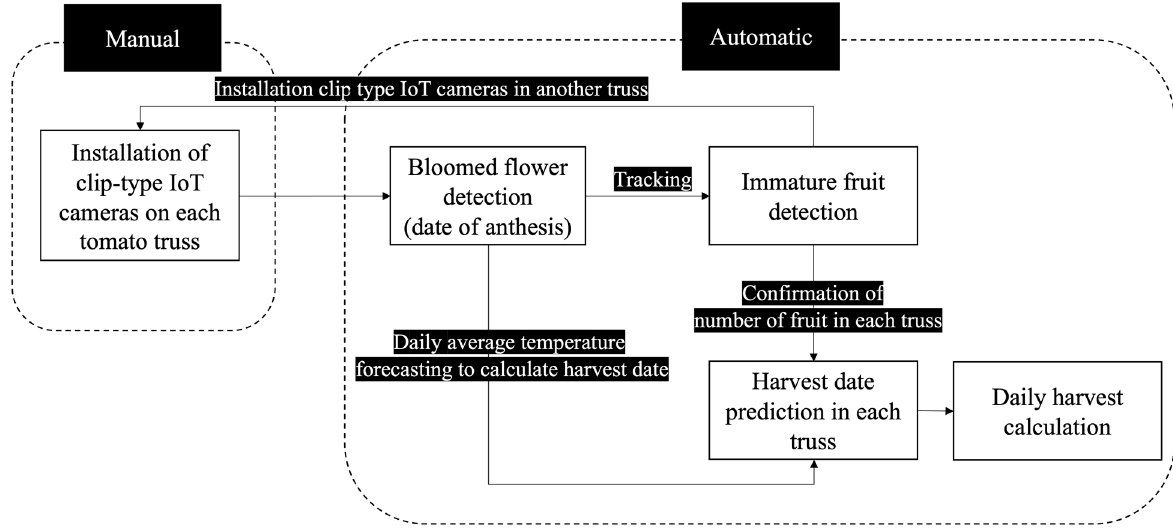
Figure 1. Pipeline of the system for tomato cultivation. IoT: Internet of Things.